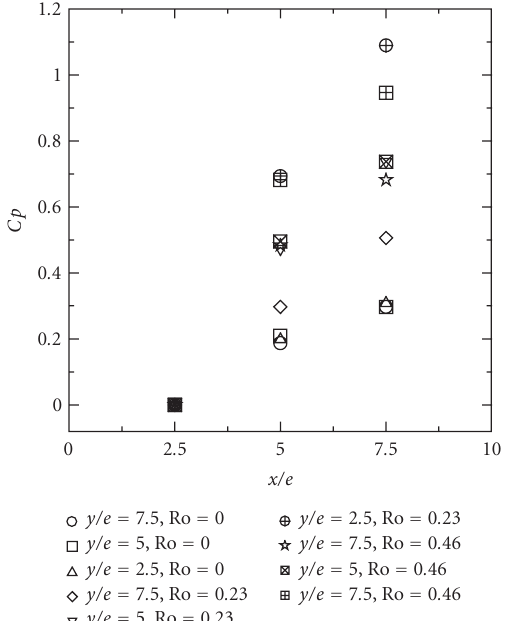
Figure 12: E ff ect of rotation number for 0 ◦ orientation at di ff erent “ y/e ” locations for a Reynolds number of 18500.